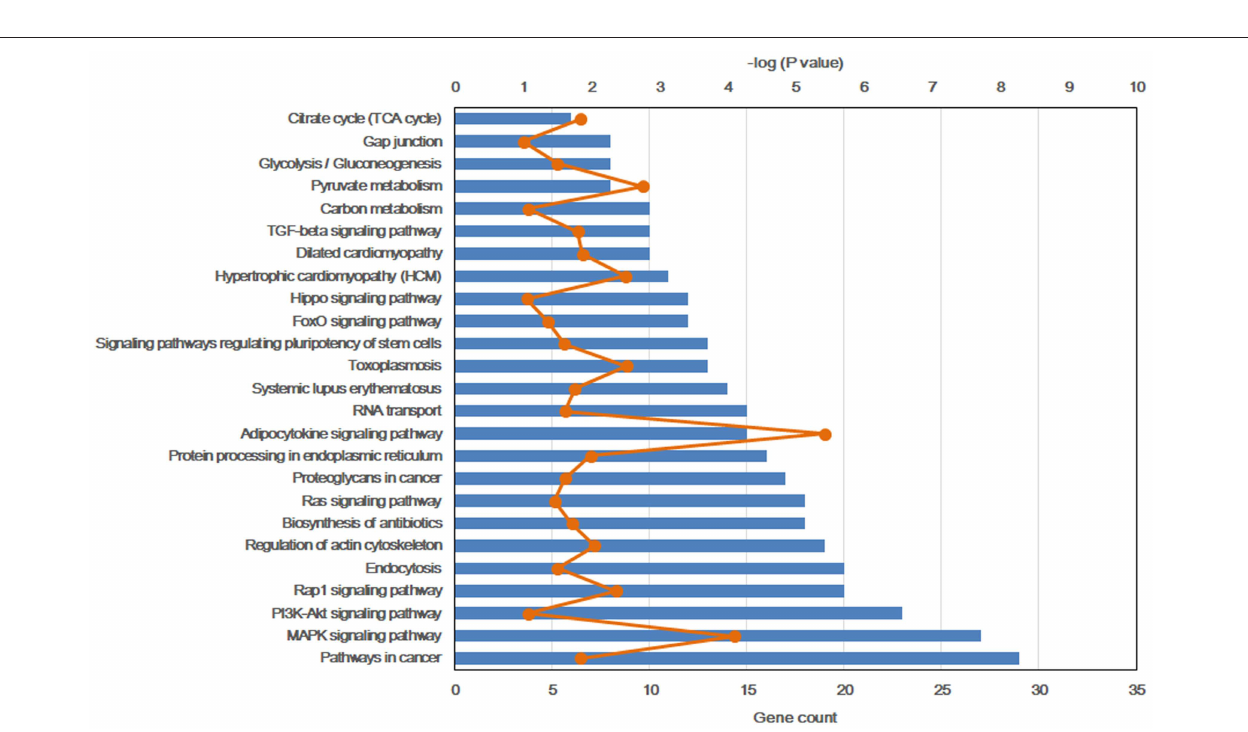
FIGURE 4 | Top 5 significant GO term of differentially methylated genes in each classification. Red, molecular function (MF); Green, cellular component (CC); Blue, biological process (BP).